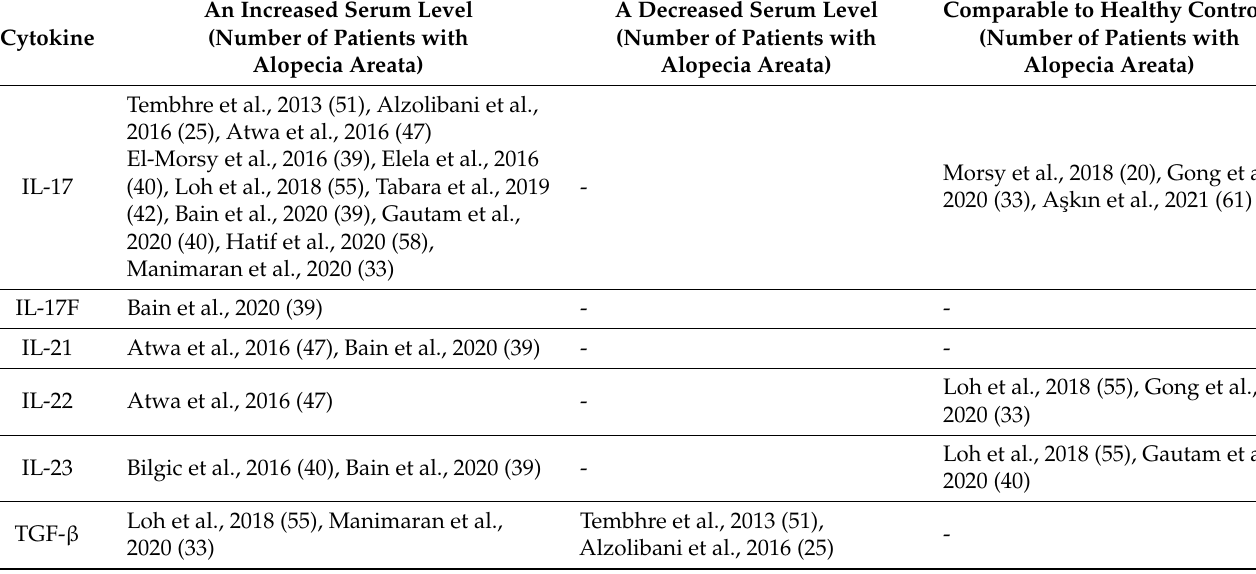
Table 3. Summary of current literature considering the serum Th17 cytokine levels in patients with alopecia areata. An Increased Serum Level Cytokine (Number of Patients with Alopecia Areata)